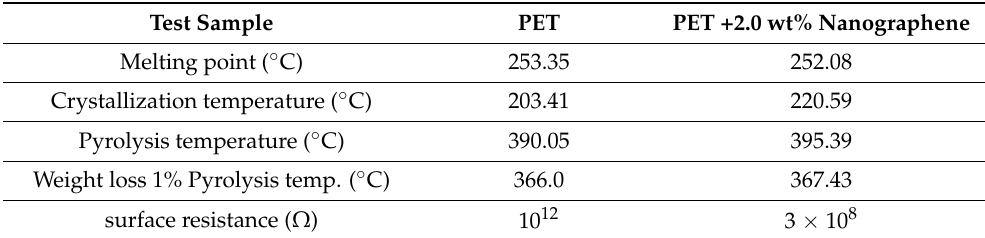
Table 27. Optimize thermal properties, surface resistance of fabrics.